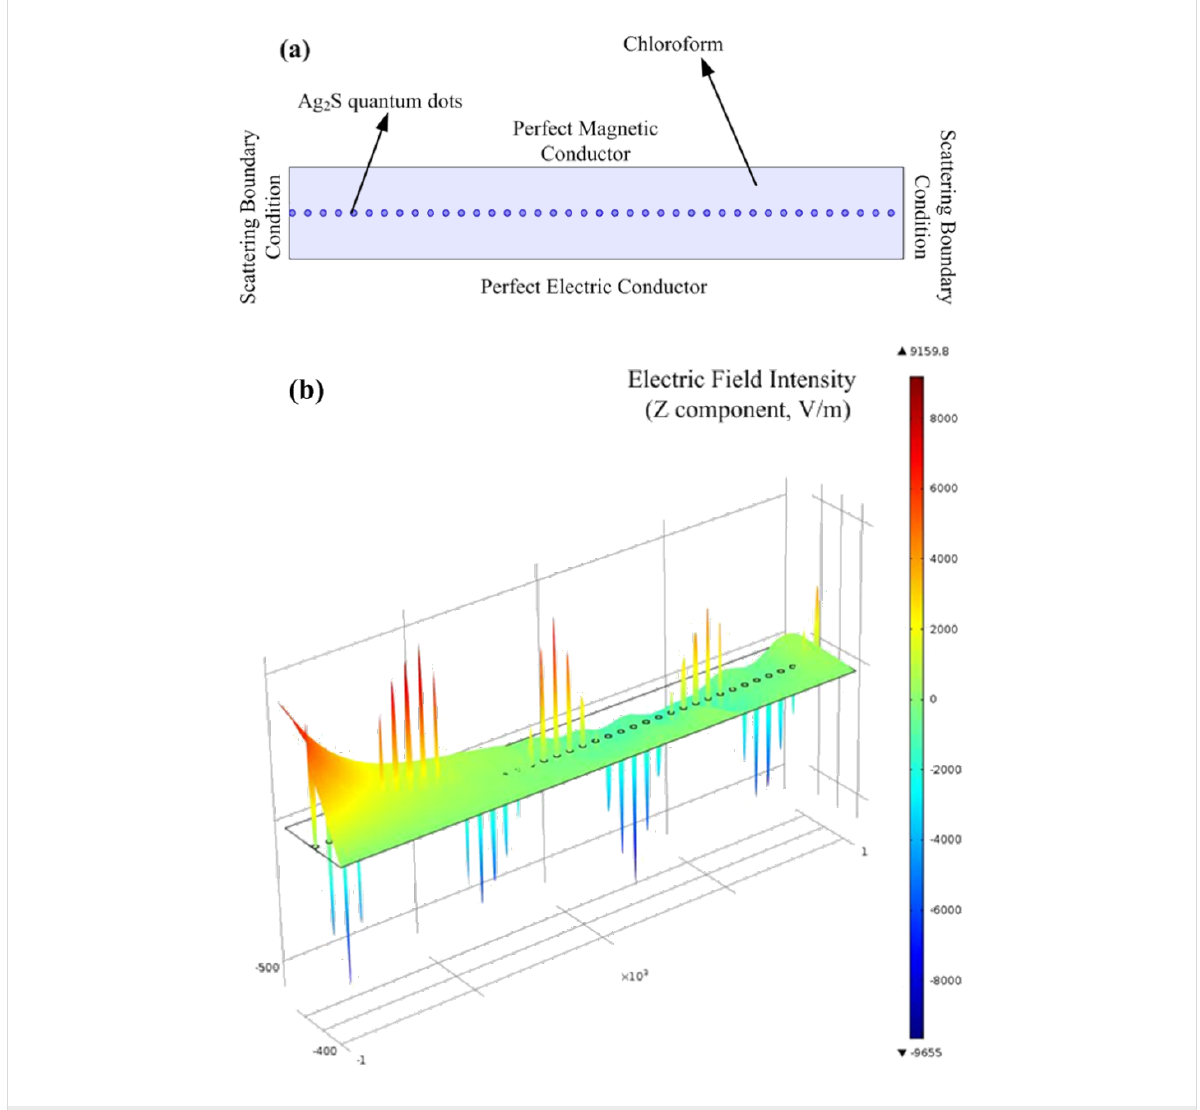
Figure 2: Simulation model (a) and result (b).